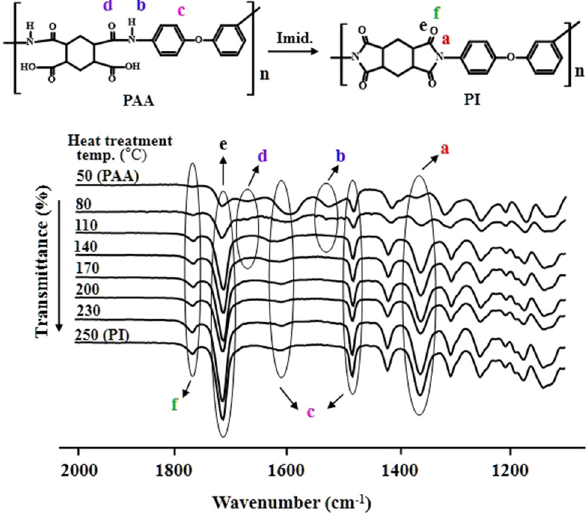
Figure 2: 1 H MAS NMR spectrum of the CPI fi lm obtained by the reaction of CHDA with 3,4 - ODA. The spinning sidebands for the aliphatic ring are marked with asterisks ( * )